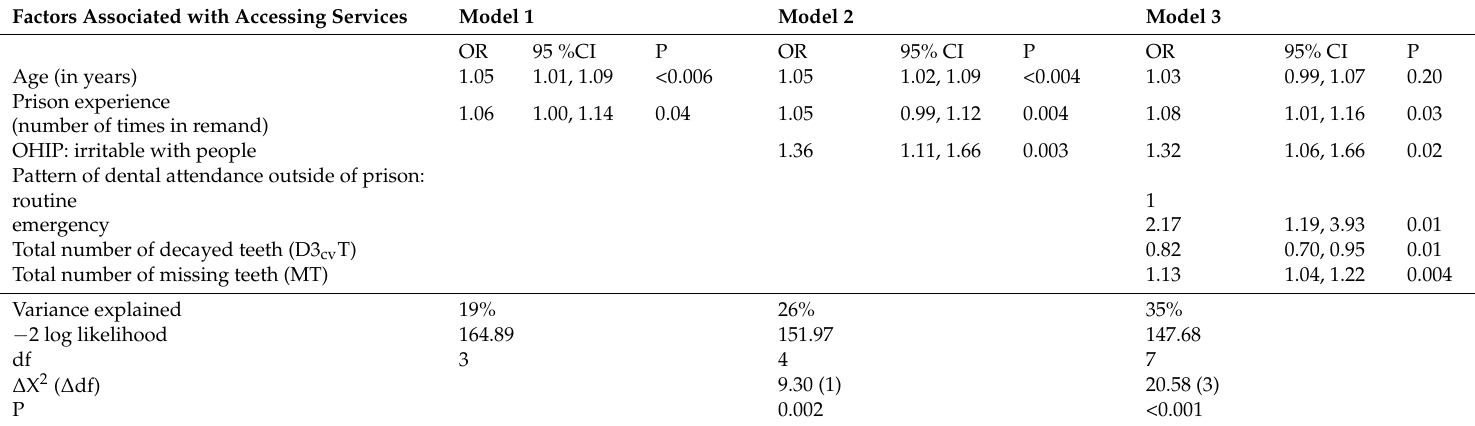
Table 3. Identifying factors associated with access to prison dental